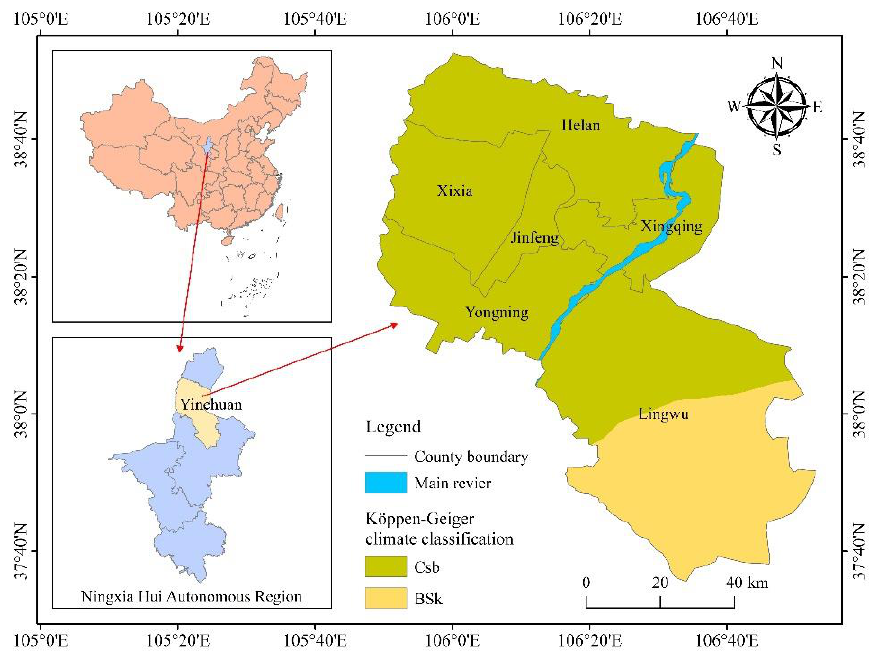
Figure 1. Location of Ningxia Hui autonomous region and Köppen classification of Yinchuan. Ningxia Hui autonomous region, highlighted in green, is located in the northwest of China. Yinchuan, as the capital of Ningxia, straddles two climate zones: the warm summer Mediterranean climate (CSB) and the cool semi-arid climate (BSK).